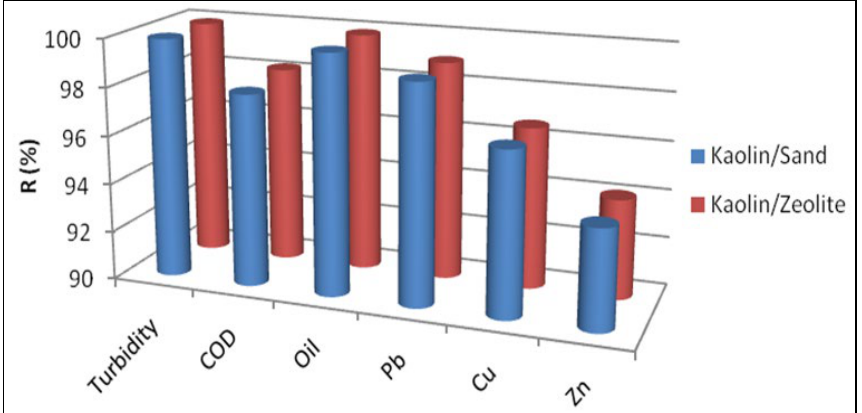
Figure 8. Retention of the different pollutants at 1 bar for kaolin/sand and 3 bar for kaolin/zeolite. Adapted from [90].